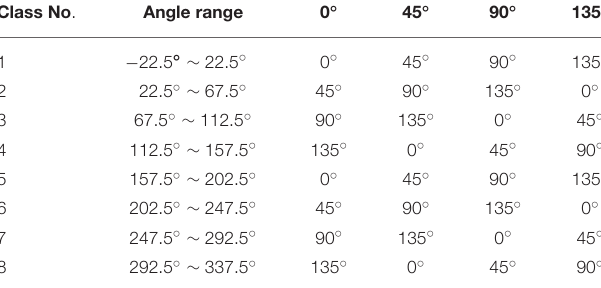
TABLE 1 | Orientation